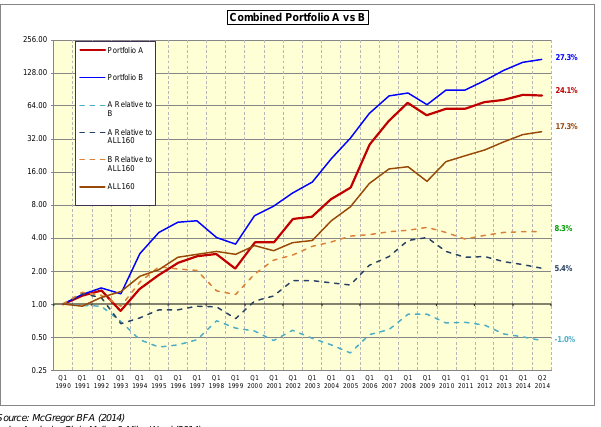
Figure 7: Buy and hold performance for fined companies (portfolio A) versus paired non-fined companies (portfolio B) Figure 7 reflects the performance of portfolio A (all of the companies included in the sample and fined by a regulatory body) and portfolio B (companies never fined) relative to each other as well as the equal weighted